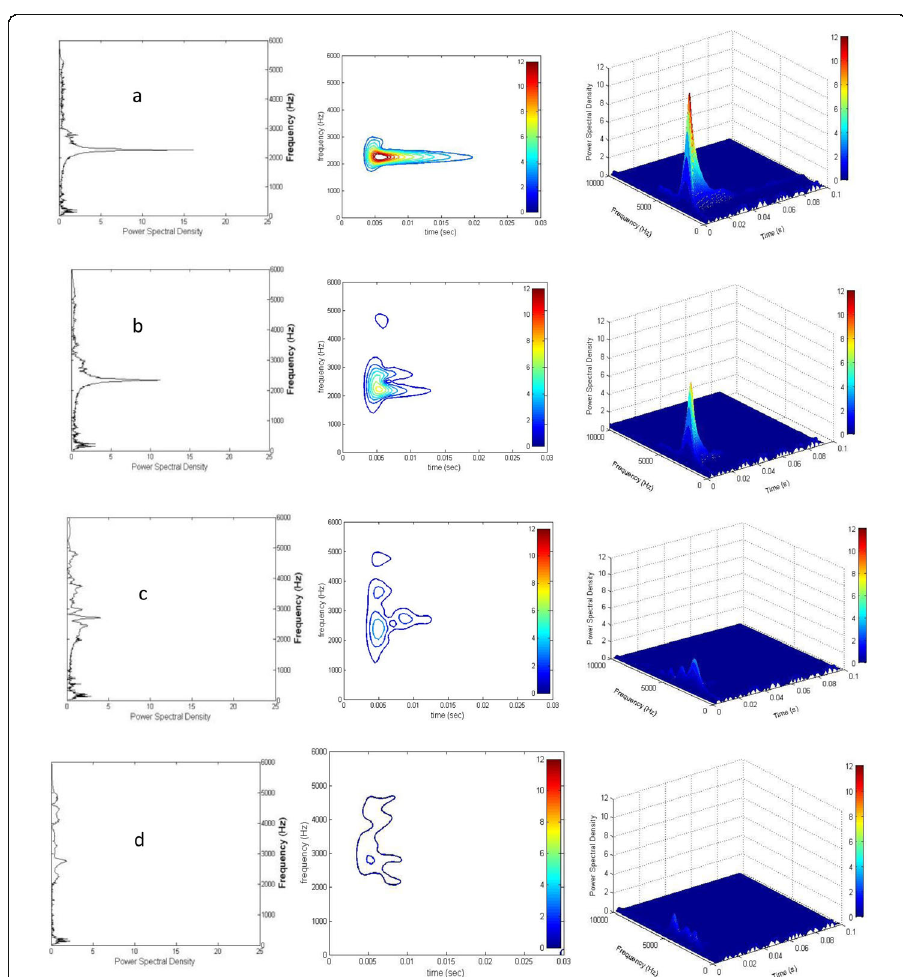
Fig. 25 Comparison of different cases of cavities by mountain shape: a 5 × 5 × 5cm. b 5 × 5 × 1.25cm. c 5 × 5 × 0.75cm. d No